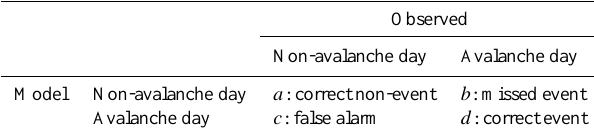
Table 2. Contingency table (total cases: N = a + b + c + d )